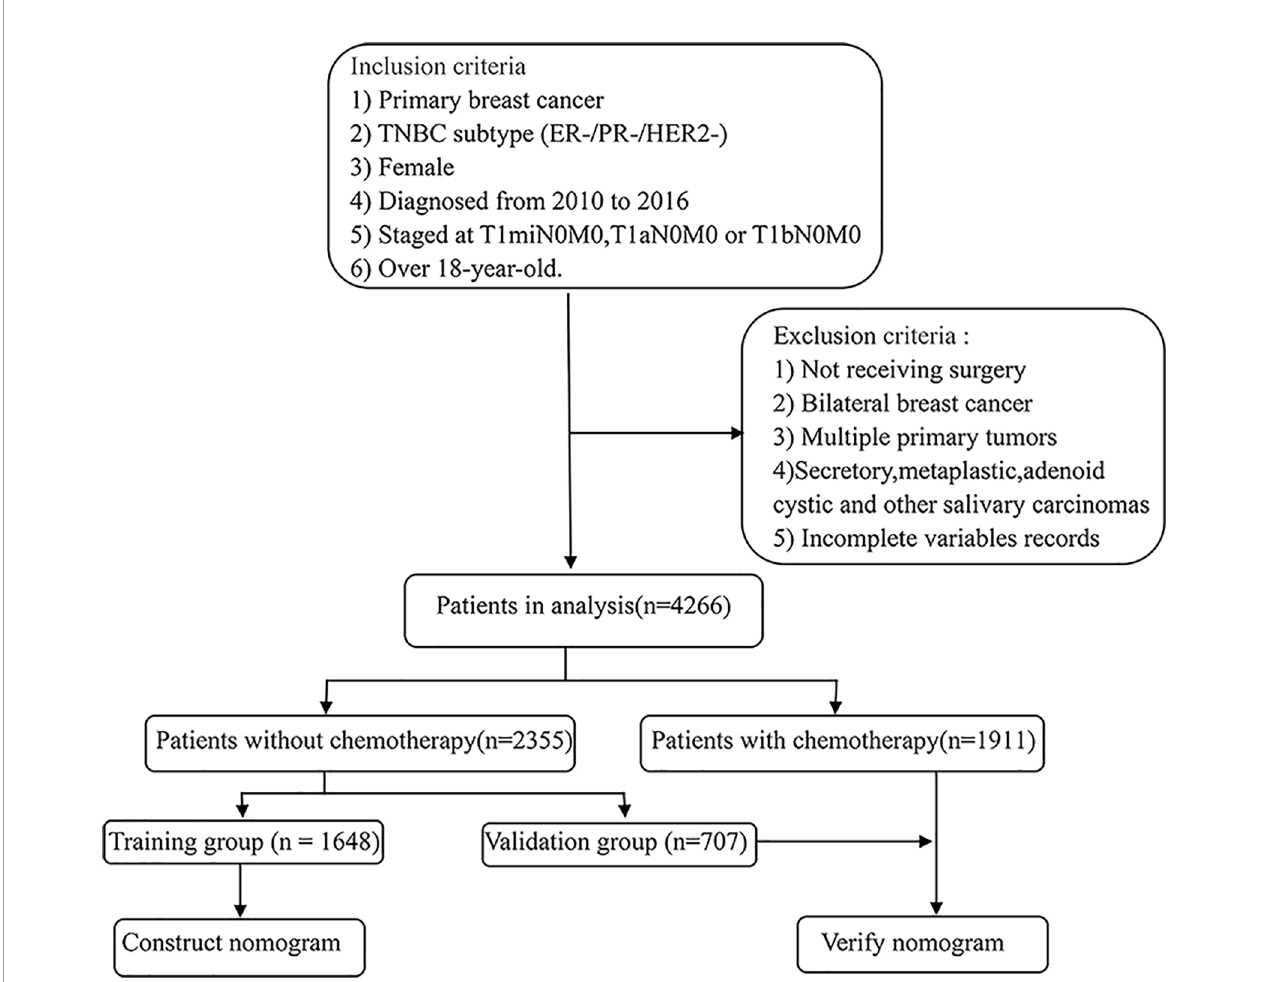
FIGURE 1 | Eligibility, inclusion, and exclusion criteria of the study population. A total of 4266 patients who met the criteria were included, of which the population who did not receive chemotherapy was divided into a validation group and a training group by